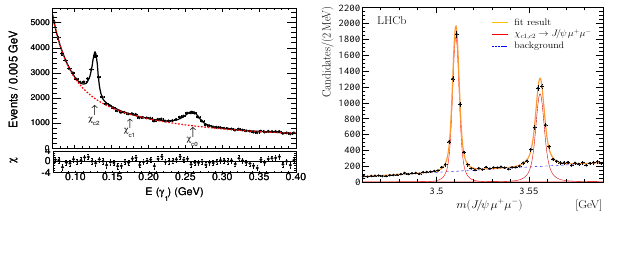
Figure 5. (Left) Fit to the energy spectrum of radiation photon [30]. (Right) Fit to the invariant mass of J /ψπ + π − [31]. Dots with error bar are for the data. The solid line denotes the fit results. The dashed line stands for the Figure7.2: Massdistributionfor J/ψµ + µ − candidatesafterthe tightselection . Thetotalfit PDFisshowninorange,the χ c 1 and χ c 2 signalsareshownbytheredsolidlinesandthe combinatorialbackgroundinblue.ThedoubleGaussianresolutionmodelisused.Theresidual andpulldistributionsareshowninFig.7.3. isevaluatedtobe47 ± 7keV /c 2 and29 ± 10keV /c 2 forthe χ c 1 and χ c 2 respectively.The 195 centralvaluesofthemassmeasurementsarecorrectedaccordinglyandtheuncertainty 196